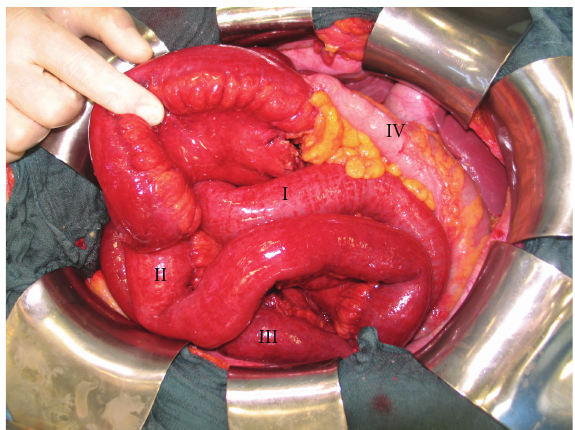
Figure 1: Operative situs after second-look laparotomy. The proximal segment of the jejunum (80cm) is slightly congested but appears to be vital (I); the congested distal segment of the jejunum and the ileum have a highly questionable viability (II and III). The transverse colon